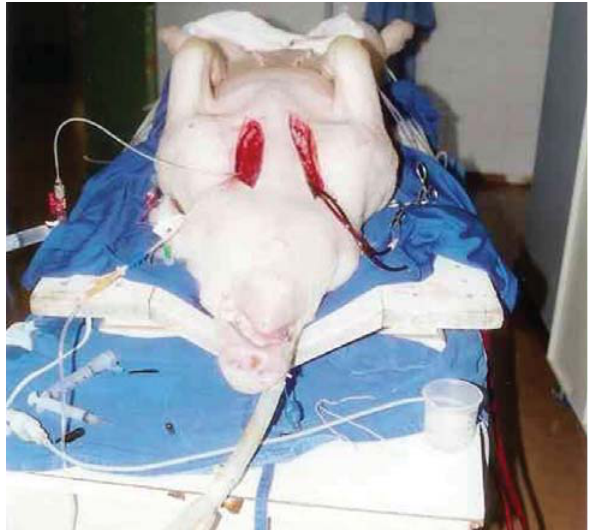
Fig. 1 - Visão geral do animal suporte em decúbito dorsal horizontal, com acessos vasculares canulados. Cervicotomia bilateral. para monitorização da pressão arterial média (PAM) de forma com tubos de ¼ de polegada. Tubagem orotraqueal e ventilação mecânica com FiO a 100% e 10 ml/kg de volume 2